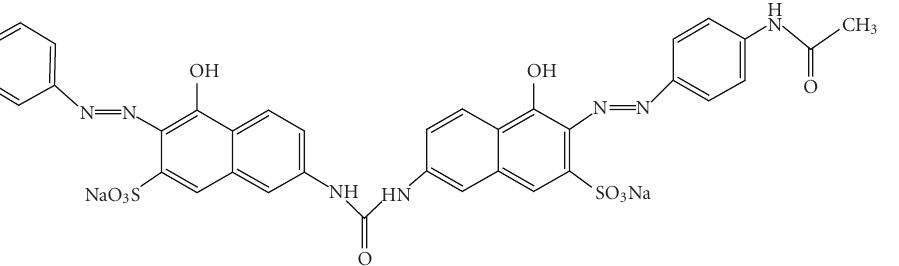
Figure 1: Chemical structure of the commercial diazo dye Direct Red 23 (C.I.